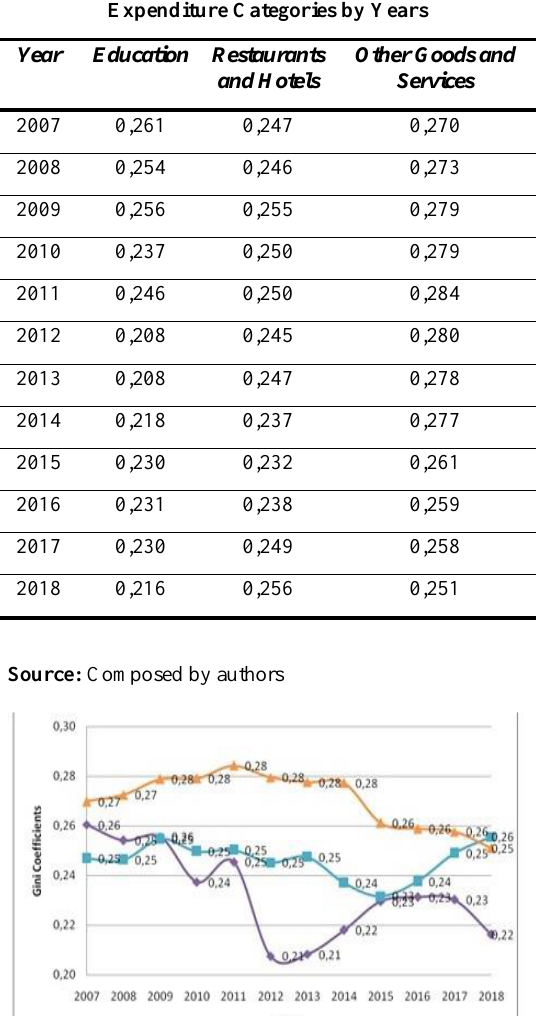
Table 4: Gini Coefficients of Education, Restaurants,